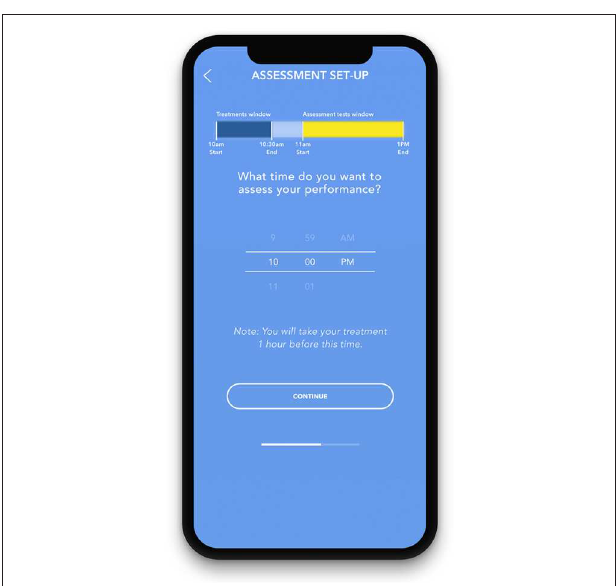
FIGURE 5 | Screenshot of assessment setup and treatment/assessment windows.